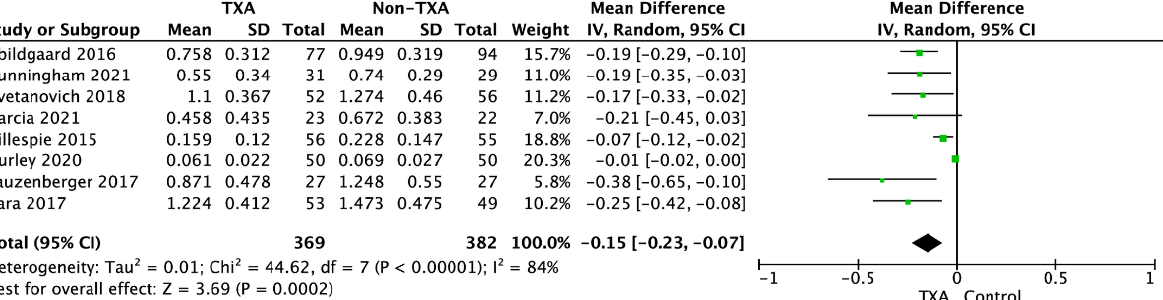
Figure 2. Forest plot of blood volume loss among TXA and non-TXA groups. The centre of each square represents the weighted mean differences for individual trials, and the corresponding horizontal line stands for a 95% confidence interval. The diamonds represent pooled results. Legend: CI = confidence interval; SD = standard